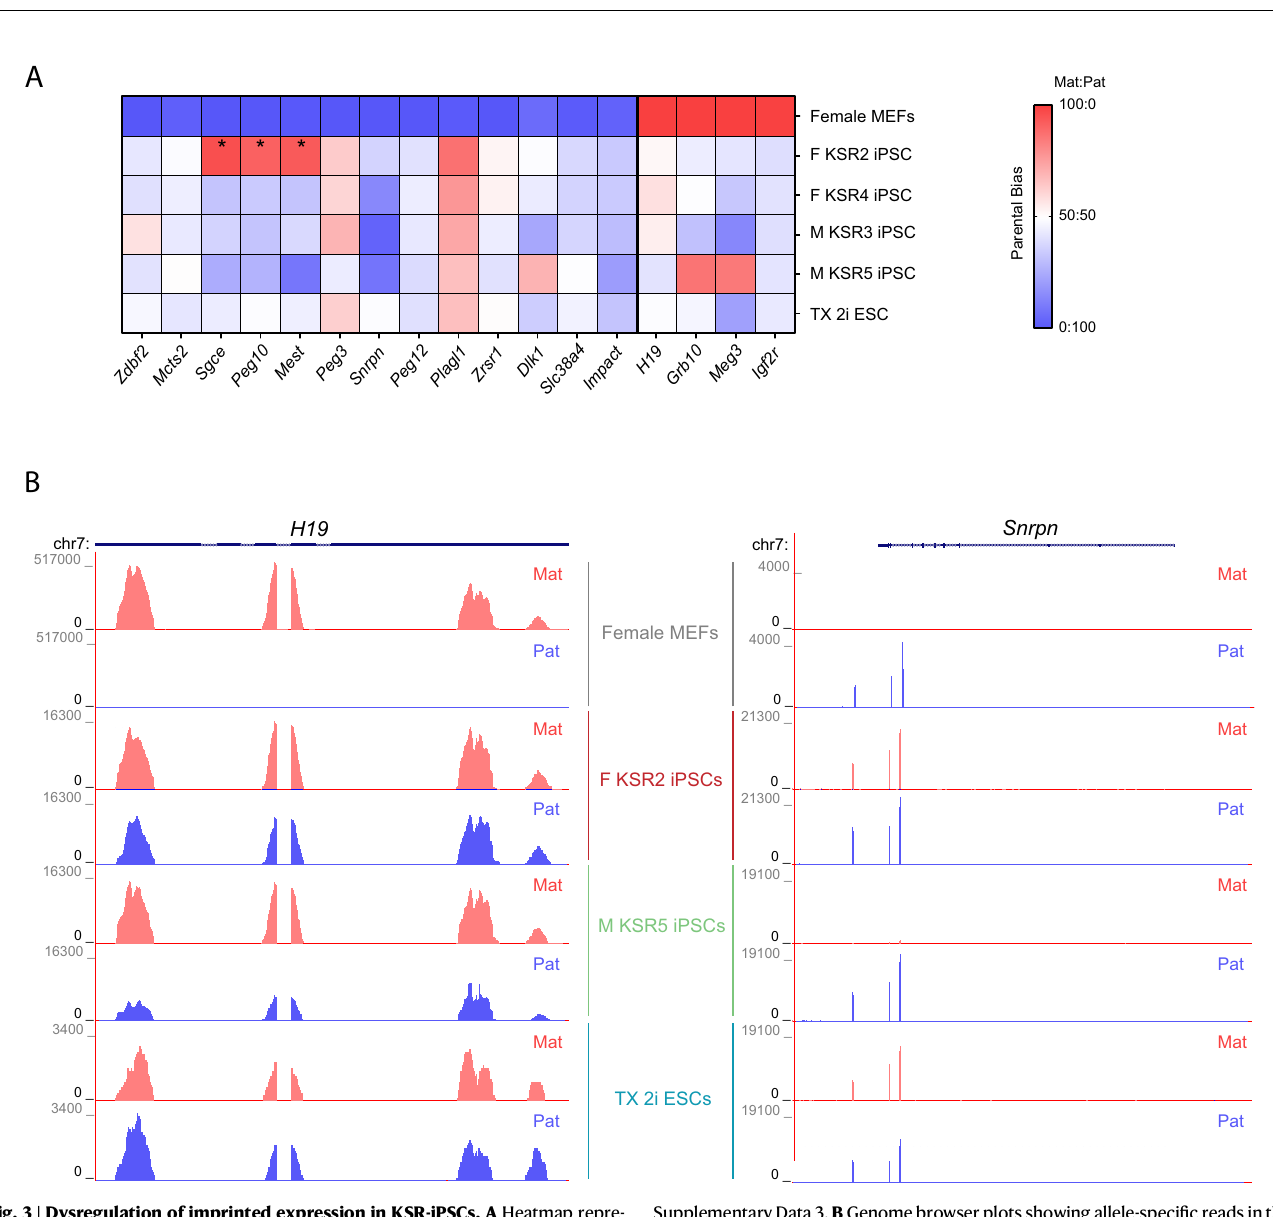
rectangles – silenced genes; regions are not drawn to scale). Source data are pro- videdasSupplementaryData2. B Averagepercentageofmethylationatmethylated andunmethylatedallelesofICRsinparentalMEFs( n =2biologicalindependentcell lines), female and male KSR-iPSCs ( n =6 each biological independent cell lines); Graph represents the mean±SEM methylationlevels measured ateachCpG within different genomic regions per parental allele for each group of samples. Statisti- cally signi fi cant differences between female and male KSR-iPSCs are indicated as * p <0.05; ** p <0.01; *** p <0.001 (unpaired two-tailed Student ’ s t -test). Source data are provided as Supplementary Data 2.